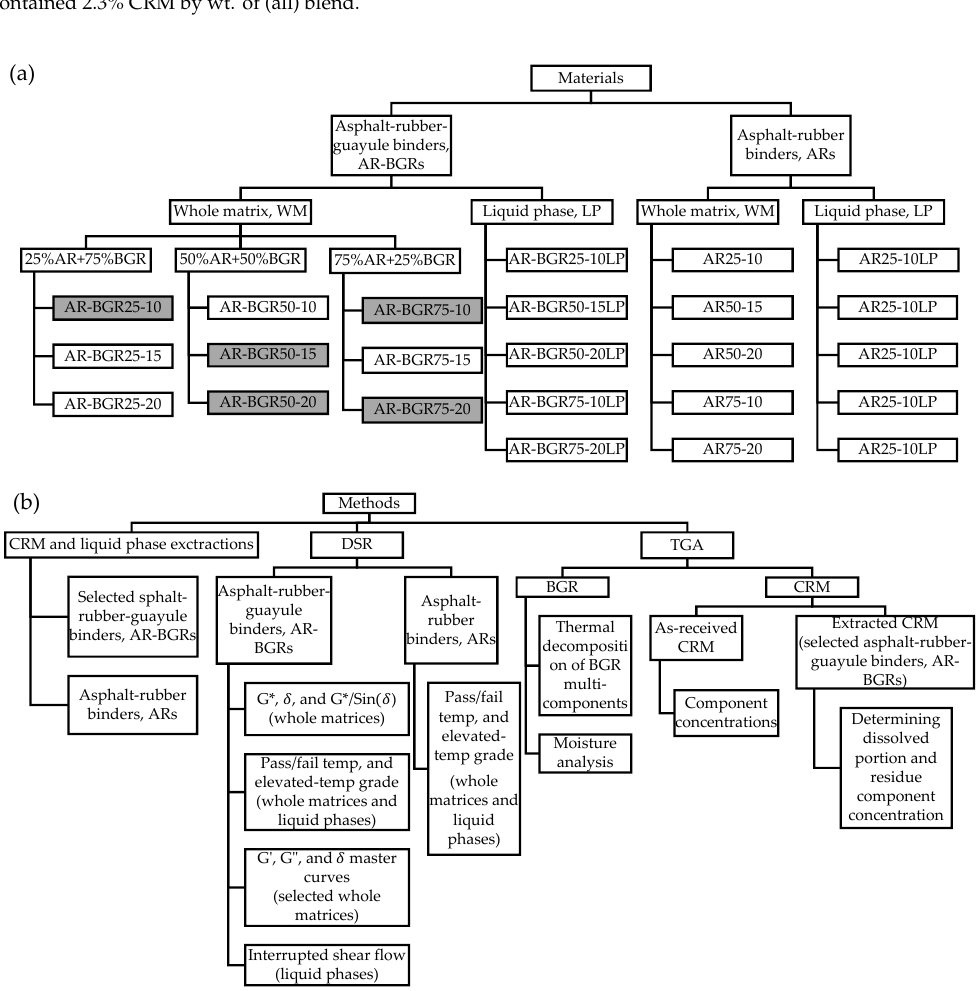
Figure 1. Flowcharts of experimental plan: ( a ) Materials and ( b ) methods. The five selected asphalt–rubber–guayule binders for the study completion are highlighted in ( a ) .